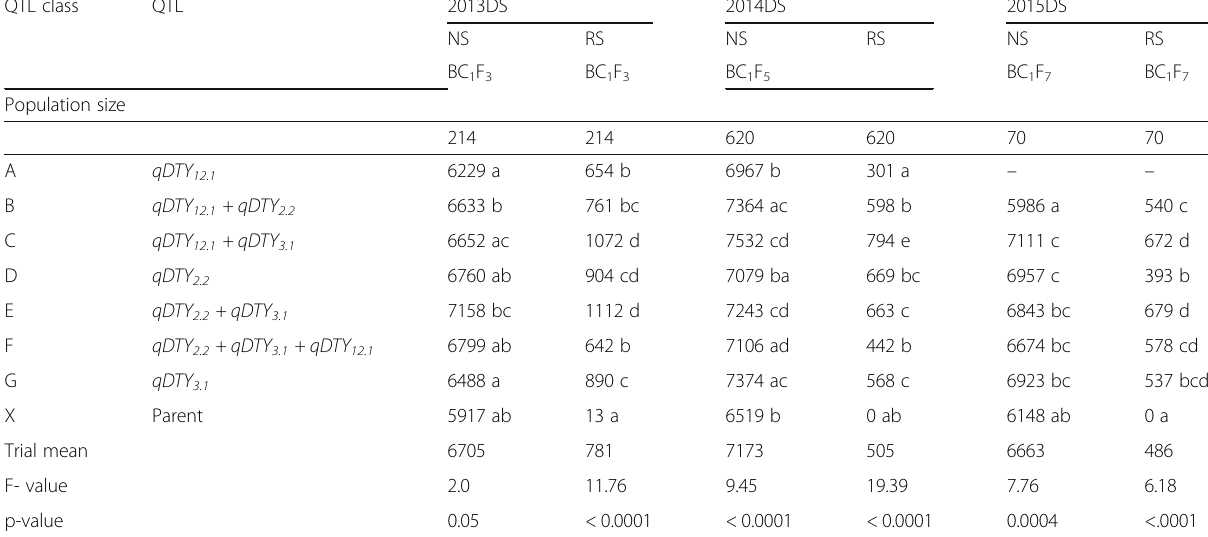
Table 5 Mean comparison of QTL classes of grain yield (kg ha − 1 ) across BC 1 F 3 to BC 1 F 7 generations under reproductive-stage drought stress and irrigated non-stress control conditions in MR219 background at IRRI,